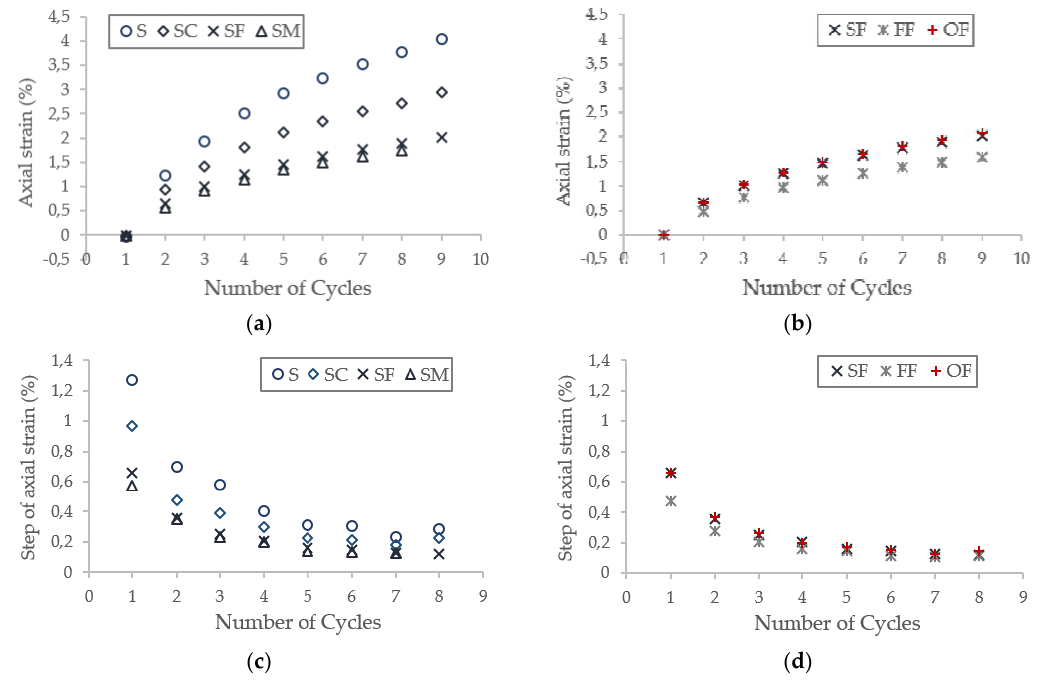
Figure 4. In each consecutive cycle: ( a ) Axial strain accumulated for the S carpet with varying ceramic sands; ( b ) Axial strain accumulated for the F ceramic sand with alternating carpets; ( c ) Step of axial strain accumulation for the S carpet with different ceramic sands; ( d ) Step of axial strain accumulation for the F ceramic sand with alternating